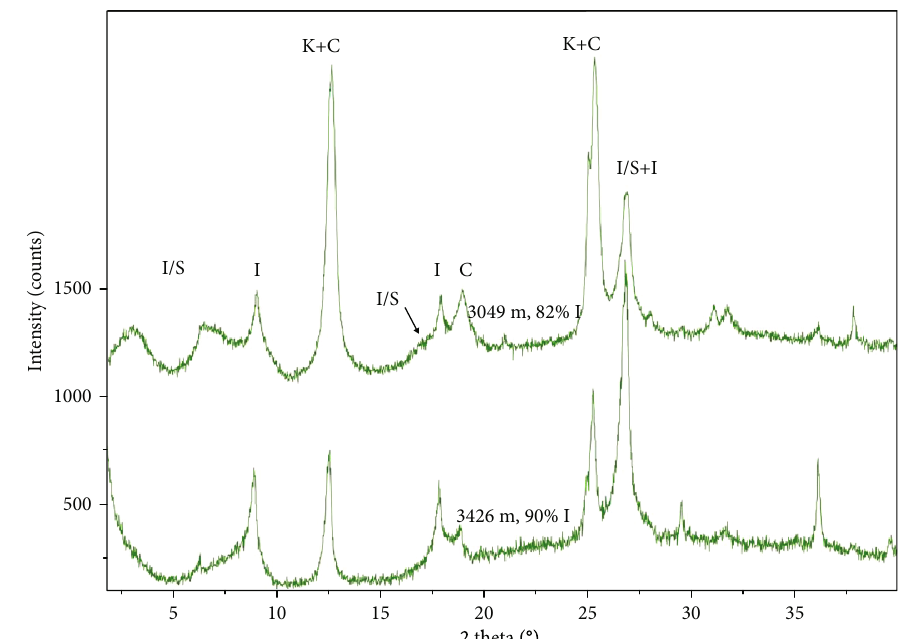
Figure 13: XRD patterns of oriented, EG-saturated < 0.2 μ m fraction samples. I/S: mixed-layer illite/smectite; I: illite; K: kaolinite; C: chlorite. Arrows show locations of I/S